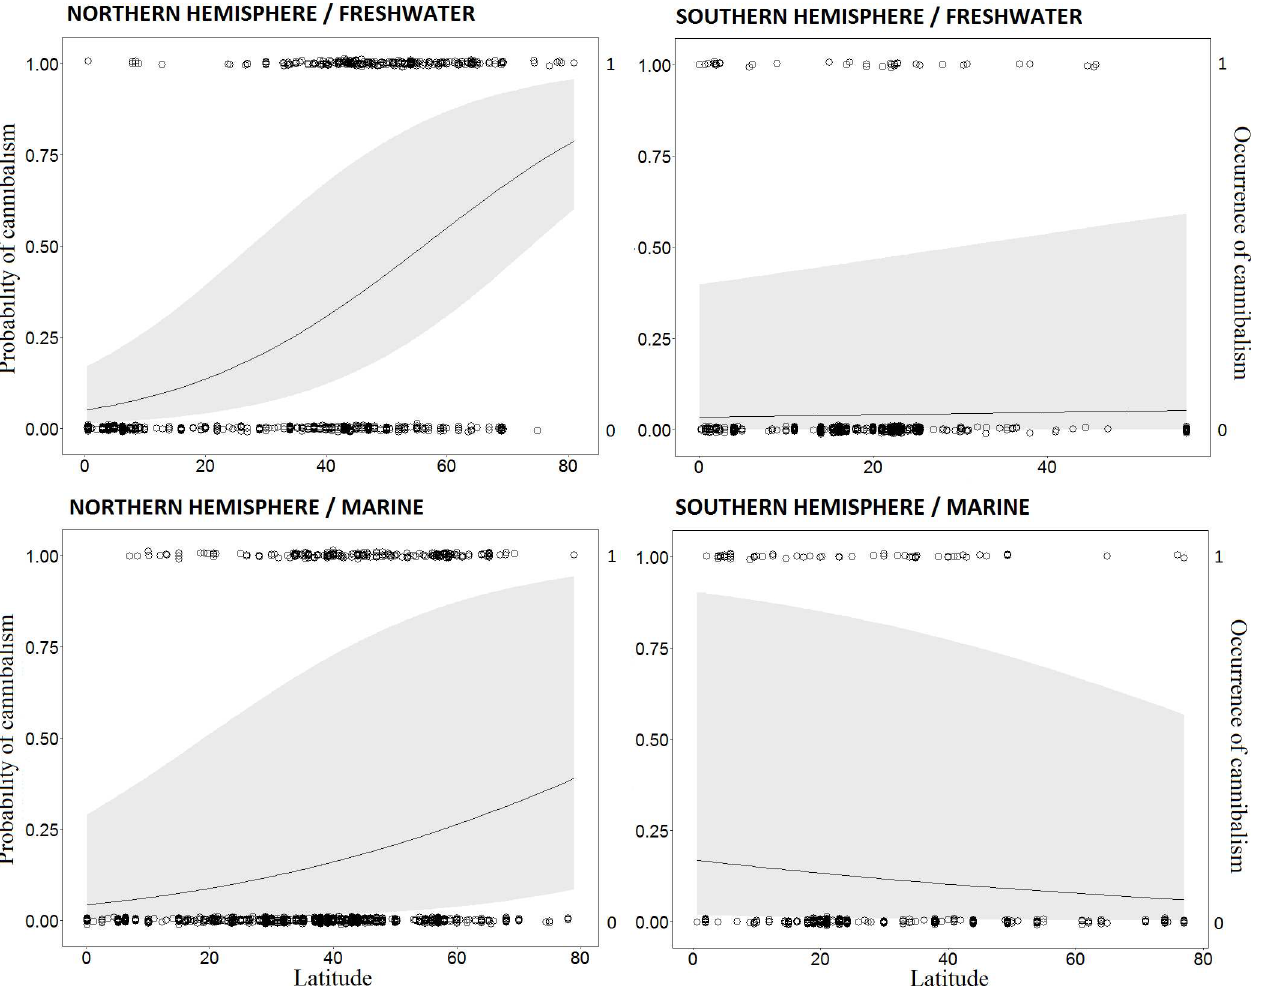
Fig 4. Generalized linear mixed models (GLMM) for the relationship between cannibalism occurrence and latitude. Freshwater (top figures) and marine (bottom figures) realm in the Northern (left figures) and Southern hemisphere (right figures). Lines are the predicted cannibalismprobabilityalong latitudinal gradients accordingto each model. Shadedareas aroundprobabilities lines represent the 95% CI. Dots are observed data for absence(0) or presence(1) of cannibalism accordingto fish species richness.